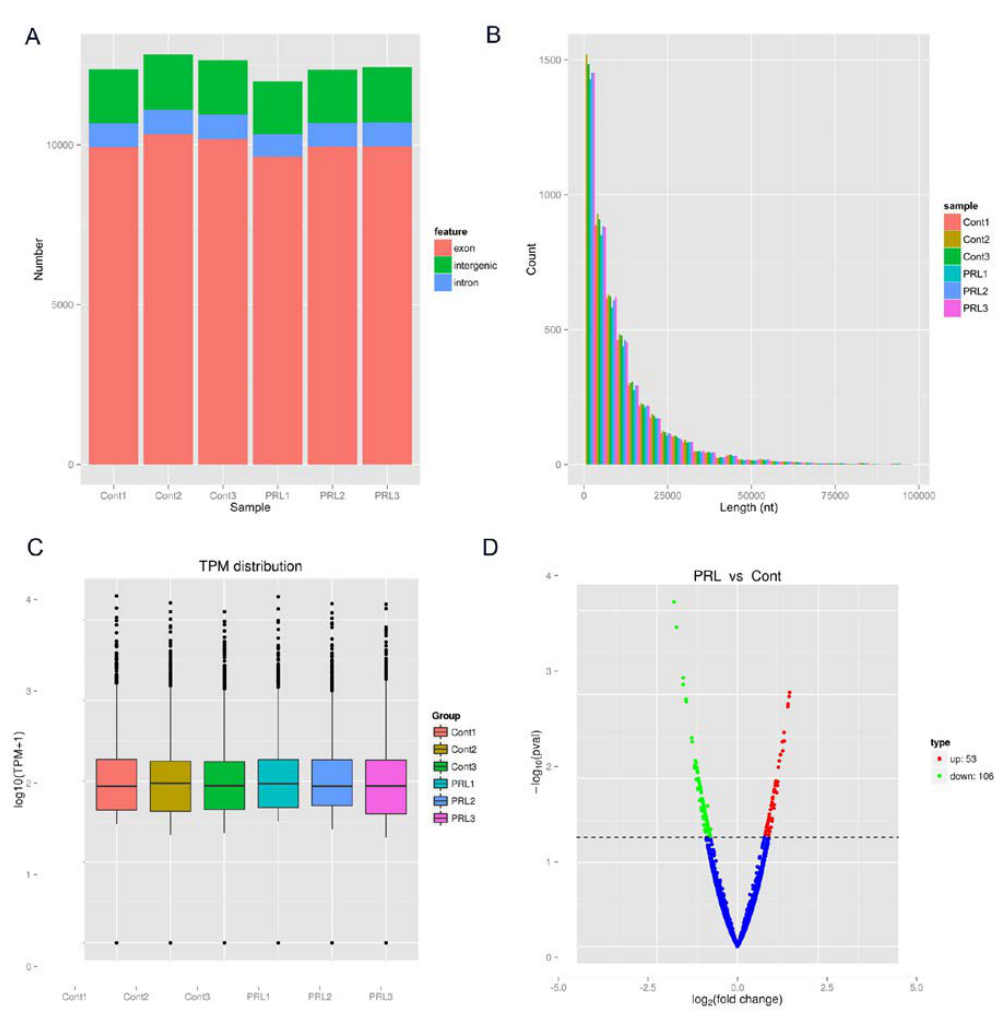
Figure 1. High expression of circRNAs in dairy cow mammary epithelial cell lines (MAC-T cells) after prolactin (PRL) treatment. ( A ) Genomic regional distribution of circRNAs in control and PRL-treated MAC-T cells; ( B ) Length distribution of circRNAs in control and PRL-treated MAC-T cells; ( C ) The box plot of the global expression of circRNAs in control and PRL-treated MAC-T cells; ( D ) Volcano plot constructed using fold-change values and p-values. The vertical lines correspond to 2.0-fold up- and down-regulation between control and PRL-treated MAC-T cells (control vs PRL), and the horizontal line represents a P-value. The red and green points in the plot represent the differentially expressed circRNAs with statistical significance. TPM reads transcripts per million.